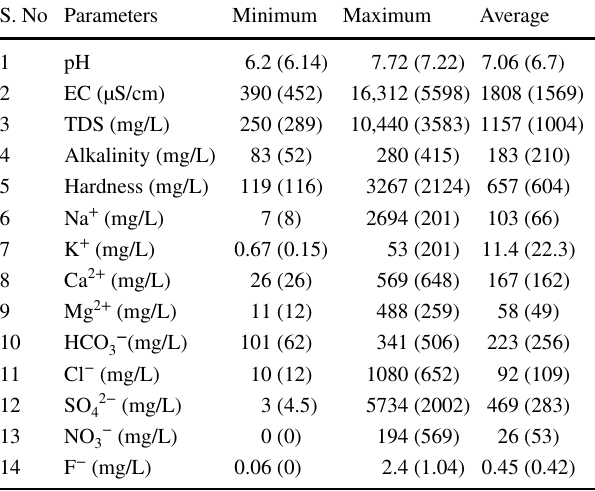
Table 3 Hydro-chemical characteristics of groundwater of the study area (pre- and post-monsoon 2019) parametersS. *Values in the parentheses represent post-monsoon values of different